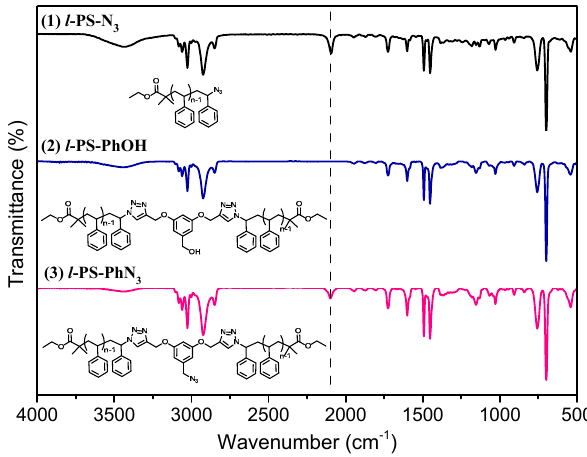
Figure 4. FT-IR spectra of l -PS-N 3 , l -PS-PhOH and l -PS-PhN 3 .